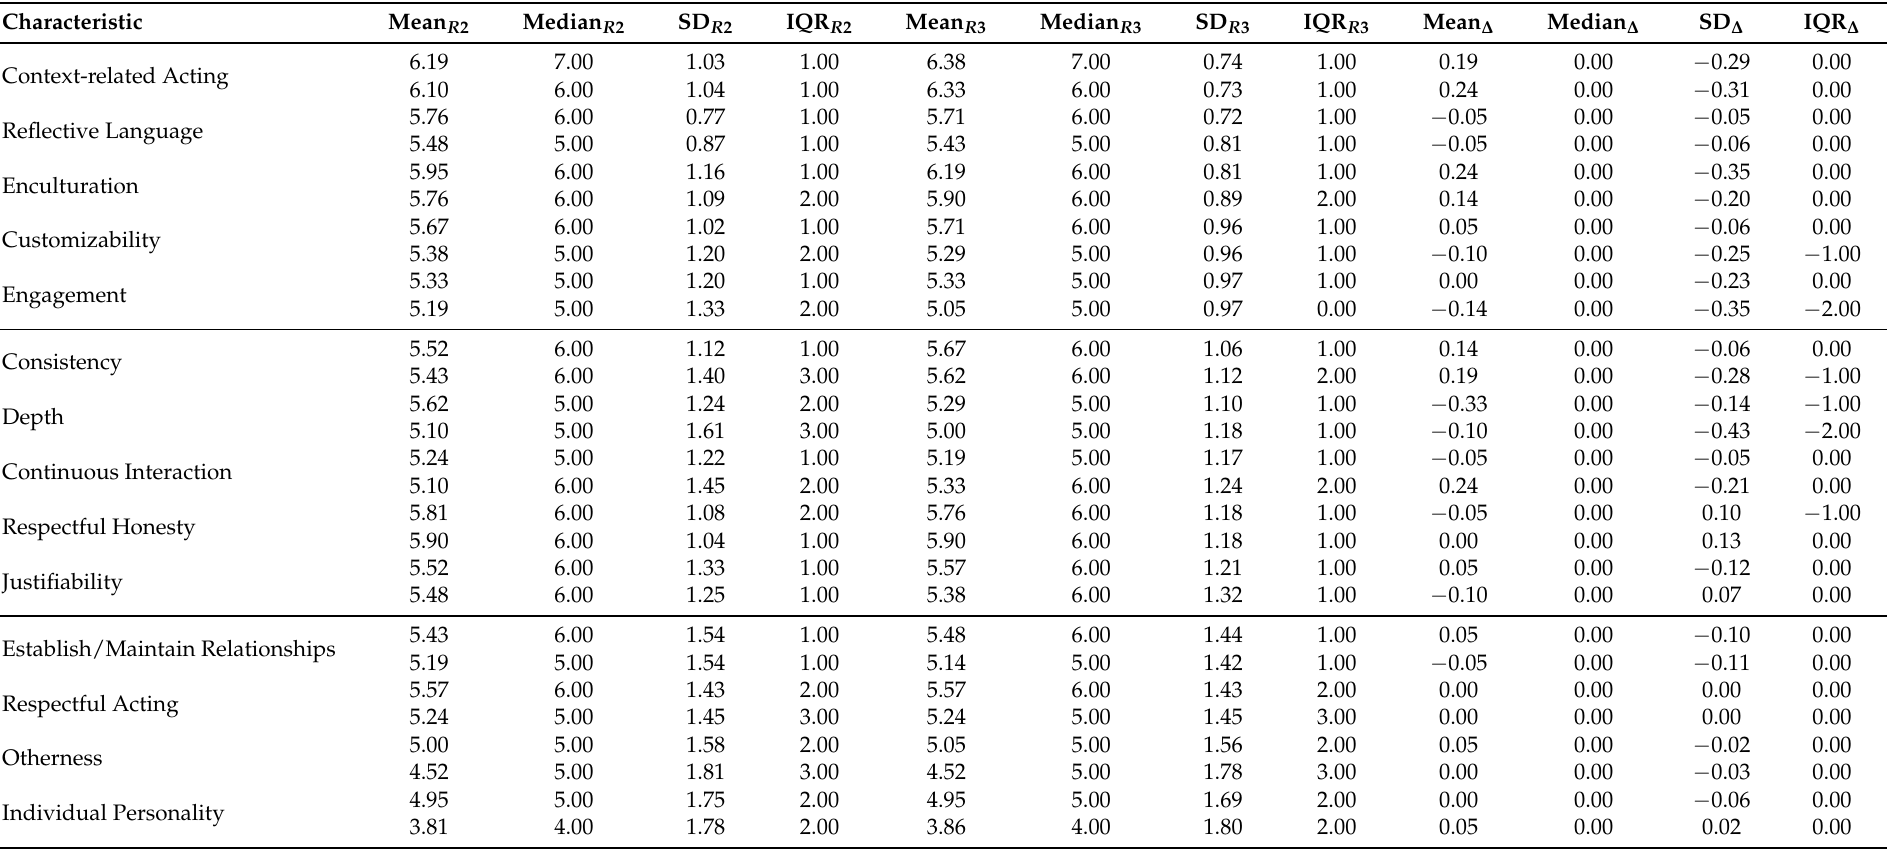
Table 3. Level of expert agreement regarding relevance (first row of each characteristic) and importance (second row of each characteristic) of characteristics identified in Round 1. Data are sorted ascending by the standard deviation in expert agreement after Round 3. We show descriptive statistics (i.e., mean, median, SD and IQR) for Round 2 (R2) and Round 3 (R3) and their respective absolute change ( ∆